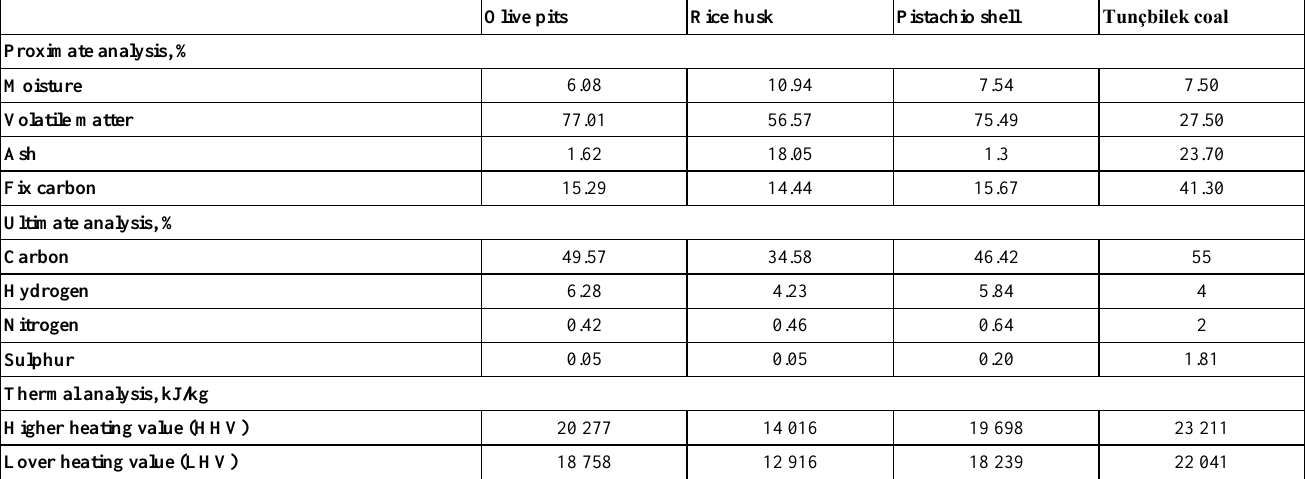
T HE CHARACTERISTICS OF OLIVE PITS , RICE HUSK , PISTACHIO SHELLS AND T UNÇBILEK LIGNITE ( AS RECEIVED ) Olive